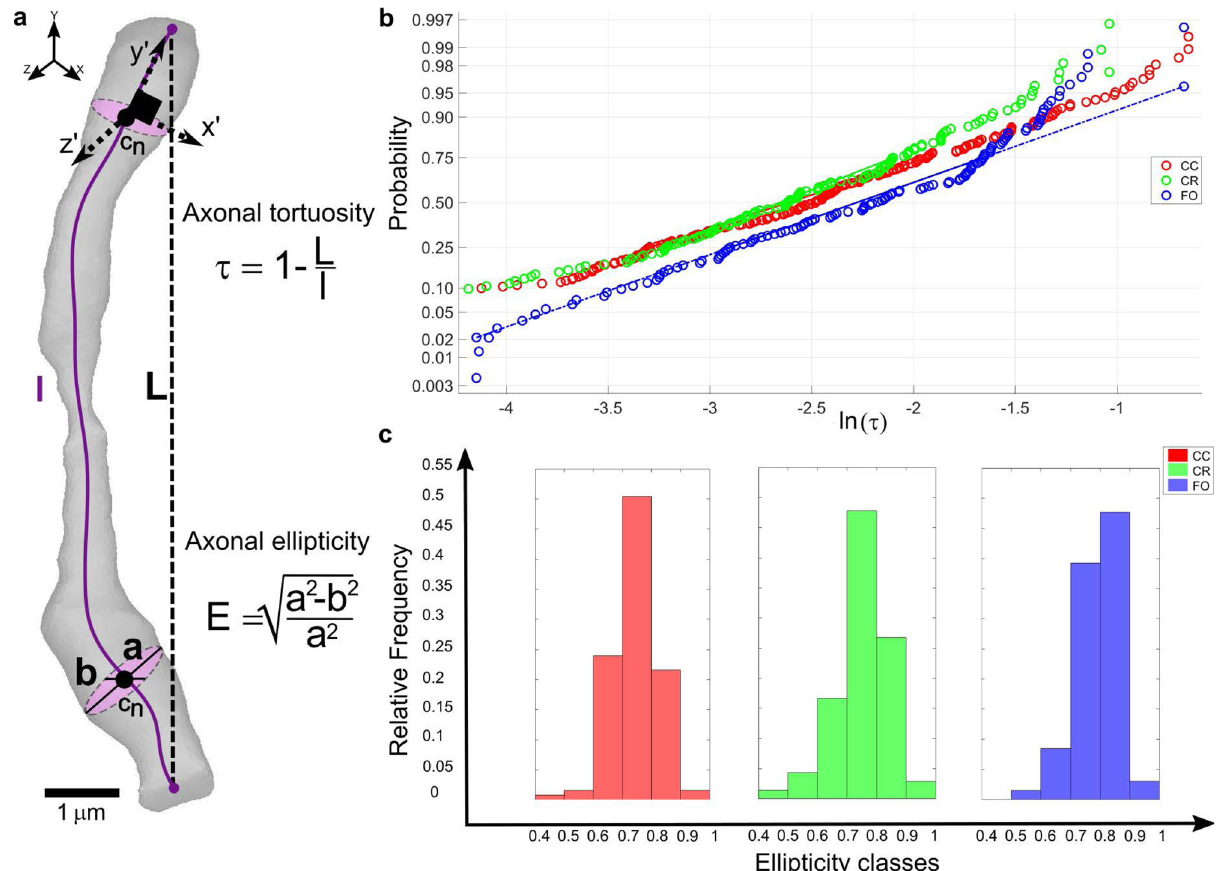
Fig. 6 Measurements of the 3D axonal structures: Tortuosity and Ellipticity. a The axonal tortuosity, τ , is measured as one minus the ratio between the length of the centerline and the calculated Euclidean length between its two endpoints. The Ellipticity is calculated as the ratio between the two semi-axes of the fi tted ellipsoid. This number quanti fi es how much the axons appear in a straight fashion. b The tortuosity values are calculated per each axon in all the samples and are categorized by area (CC in red, CR in green and FO blue) and their logarithmic value is calculated. This was performed because if τ is log-normally distributed, then ln( τ ) has a normal distribution. Therefore, their quantiles are plotted via a Q-Q plot against the quantiles of a theoretical normal distribution (dashed blue line) to see whether CC, CR and FO tortuosity values are log-normally distributed and how they differ from each other. CC, CR distributions show with some deviation from the theoretical normal distribution on the right end side of it. Interestingly, FO seems to re fl ect its differences with the other two areas also in these measurements with its distribution misaligned from the other two and a much more different behaviour towards the right end side of the graph. c It is common to represent the axons as cylindrical entities but the ellipticity values measured here show axons that appear rather elliptic in all of the areas with most of the relative frequency concentrated between the ellipticity values of 0.6 and 0.9, with the FO having a more accentuated elliptical shape con fi ned between the higher values of 0.7 and